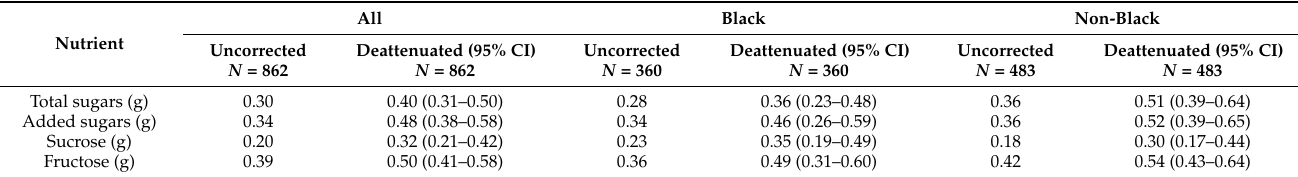
Abbreviations: CI = confidence